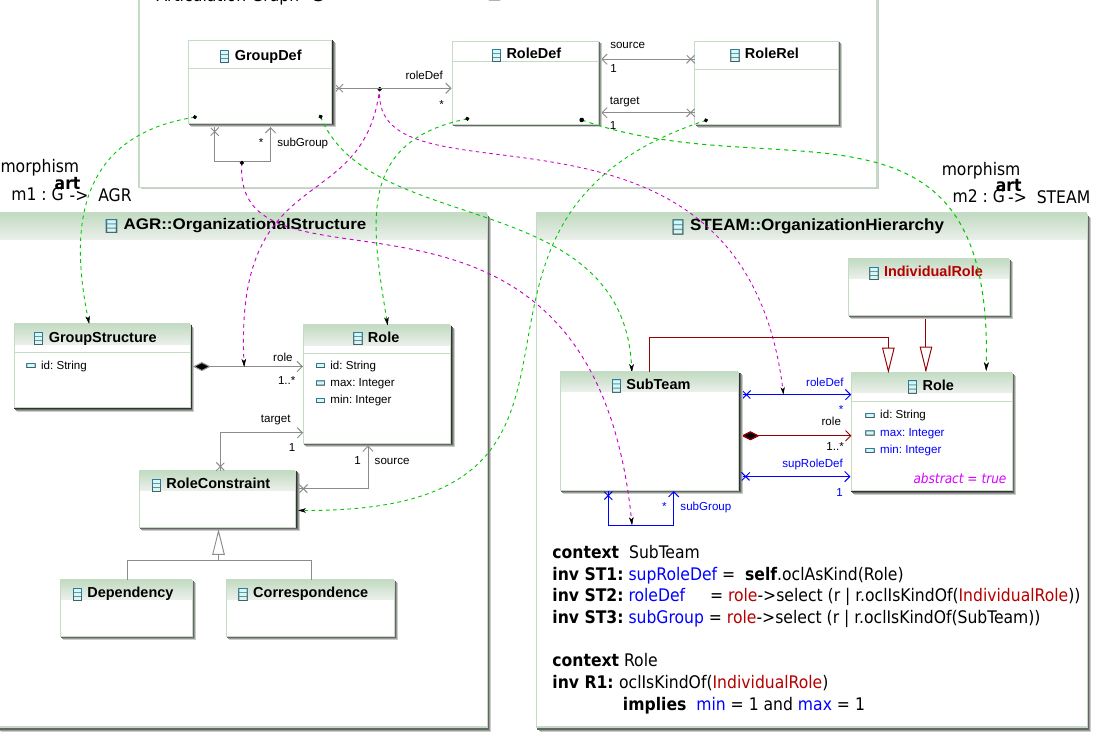
Figure 6. Alignment between AGR and